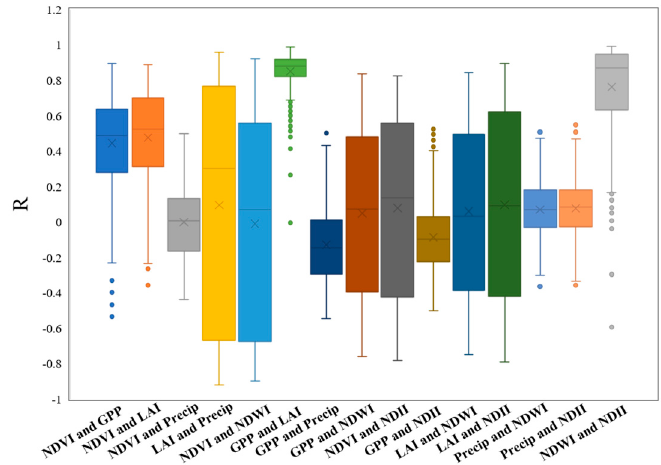
Figure 6. Statistical box chart of the correlation coefficients among the VWC-related indices .